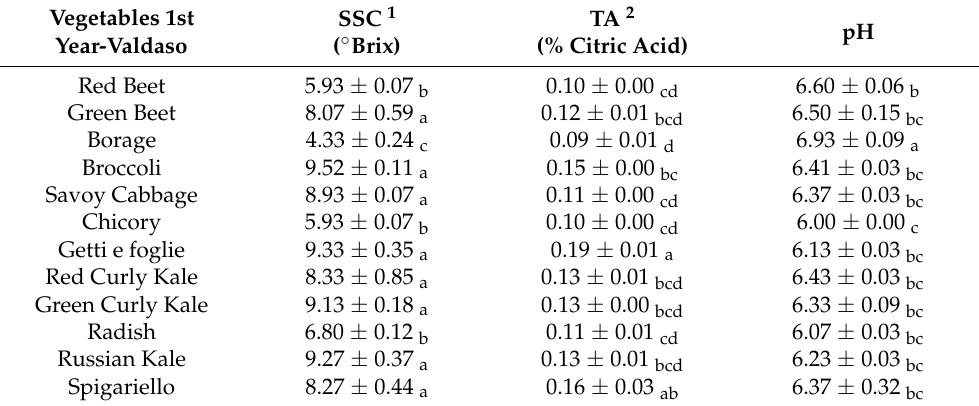
Table 2. Sensorial quality parameters of vegetables cultivated during 1st year (2016) of trial in Valdaso area.